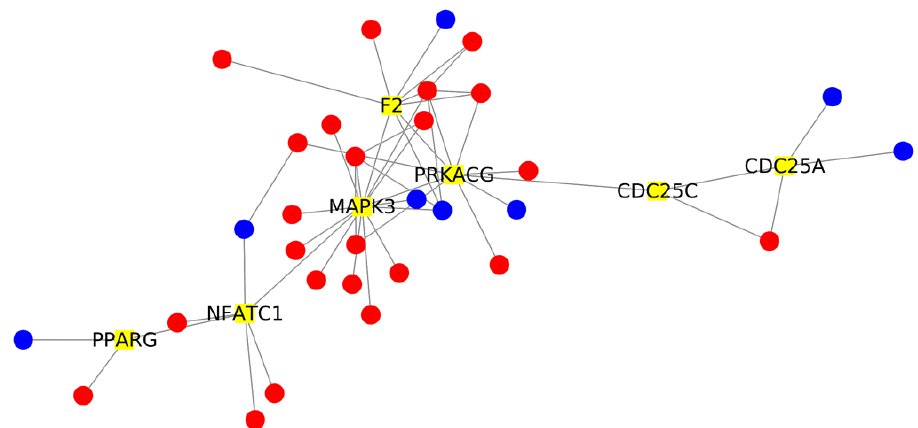
Figure 1. Network analysis of DEGs interacting with the 7 DEGs with the highest betweenness centrality. The network is composed of 38 nodes. The 7 key DEGs with the highest betweenness centrality are highlighted in yellow. The 31 interactor DEGs identified in the network are depicted in red if they are more expressed in the AD+COVID than AD cohort; otherwise, they appear in blue. We made the same things for DEGs in Table 2 of the AD against AD+COVID-19 comparison, and the 265 DEGs are represented in Figure 2.